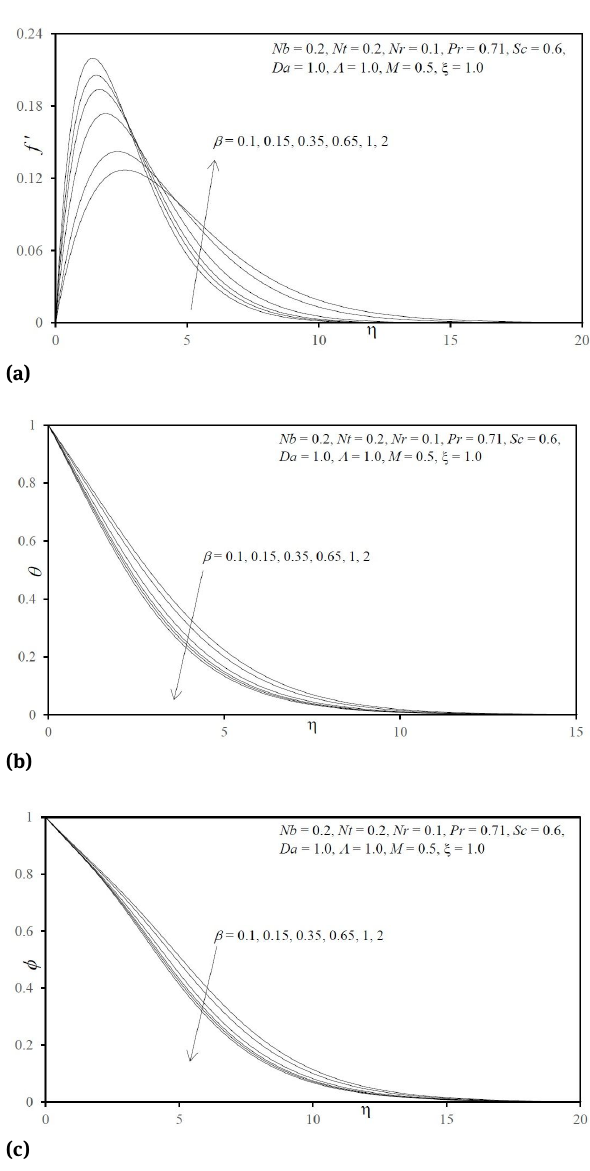
Fig. 3: (a) Influence of β on Velocity Profiles; (b) Influence of β on Temperature Profiles; (c) Influence of β on Concentration